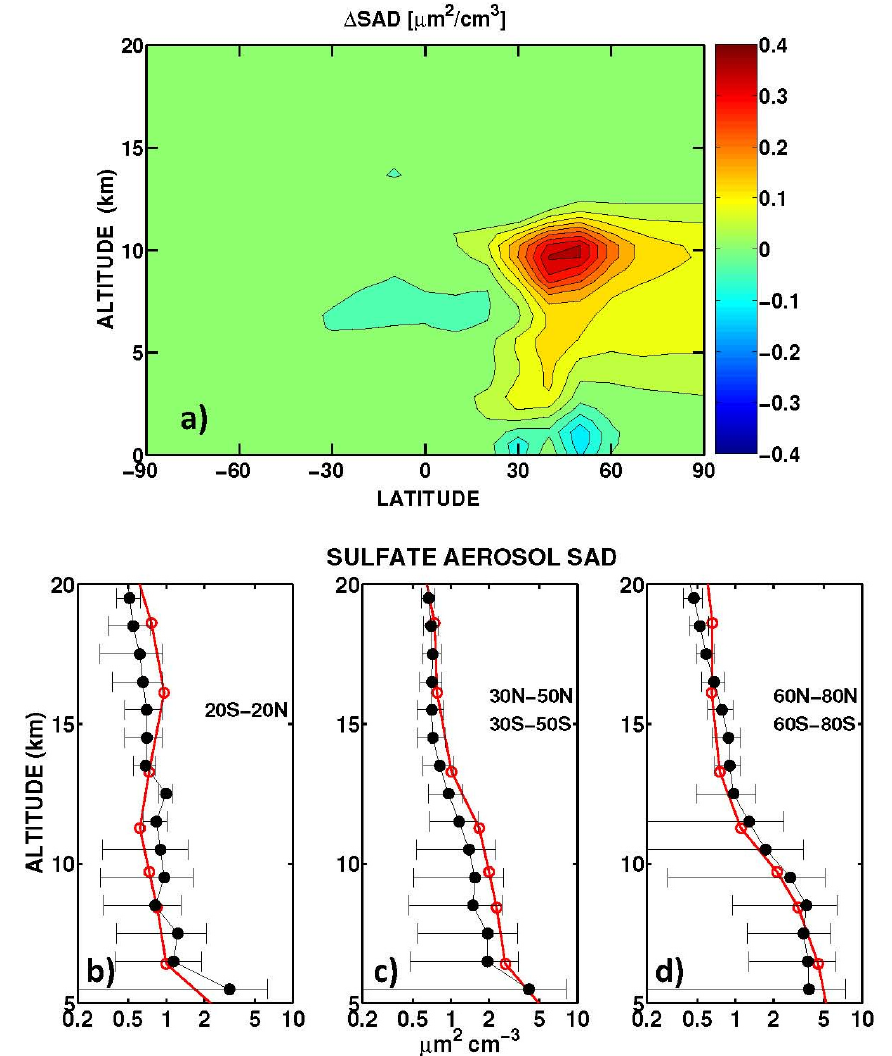
Figure 5. Top panel ( a ): zonally and annually averaged perturbations of sulphate aerosols surface area density, due to aviation emissions and calculated in the ULAQ model. Bottom panels ( b – d ): ULAQ model calculations (red line) and SAGE-II derived values (black line with circles and uncertainty bars) of sulphate aerosol SAD, shown as vertical profiles at different latitude bands: tropics (left panel (b)), mid-latitudes (mid panel (c)) and high-latitudes (right panel (d)) (average 1999–2002). Units are μ m 2 /cm 3